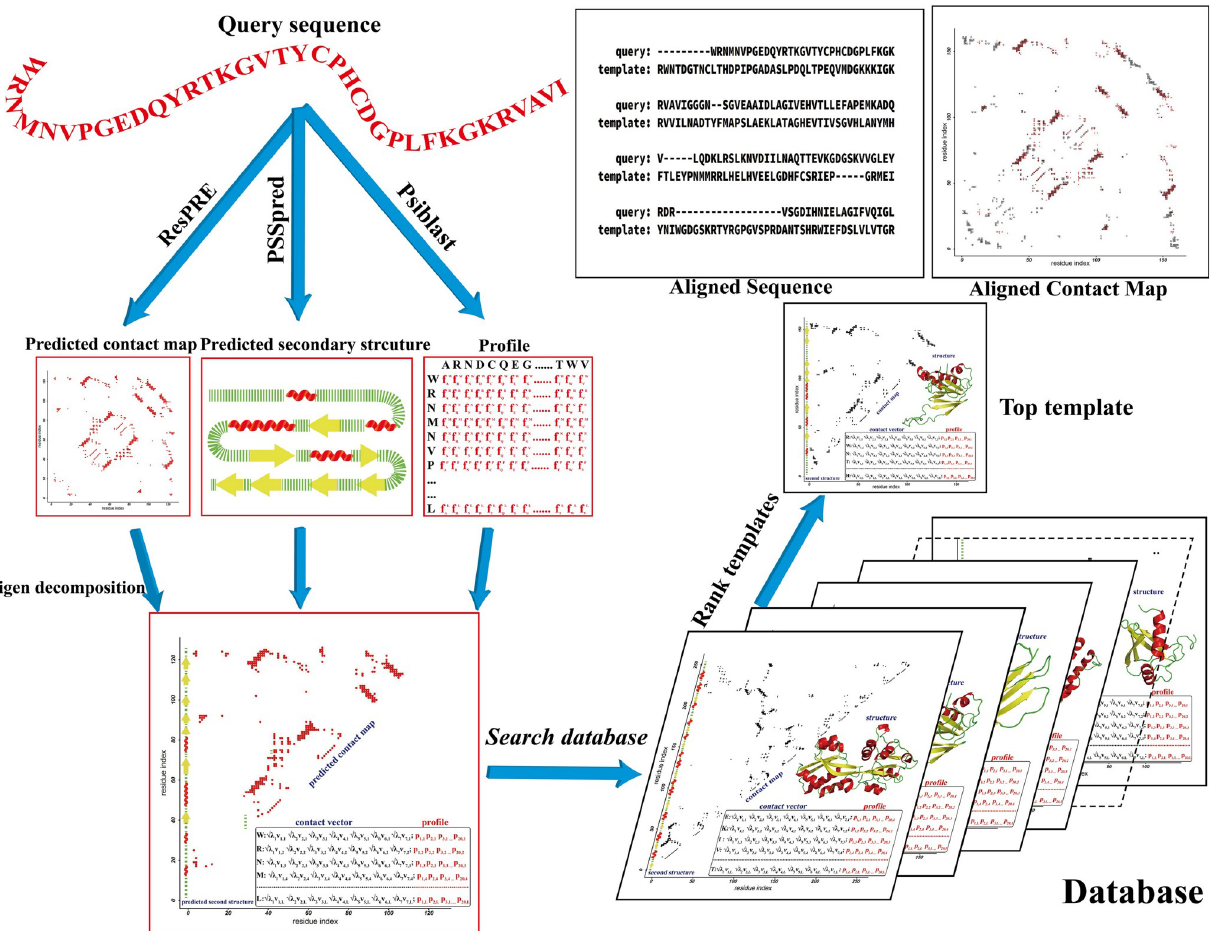
Fig 1. CEthreader flowchart. The pipeline consists of four major steps: contact map prediction, contact matrix eigen-decomposition, database searching and contact score-guided template selection.